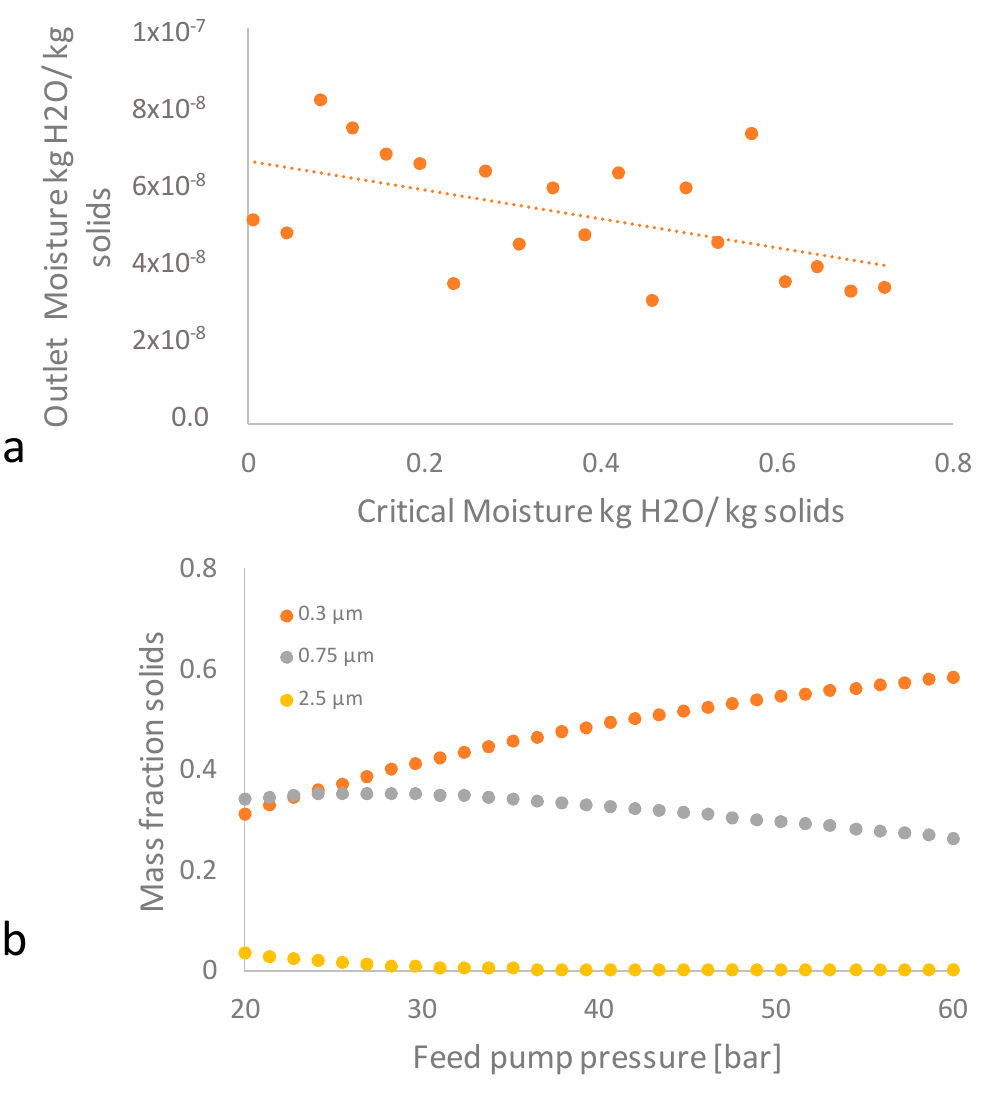
Figure 15. Sensitivity analysis at constant temperature of 52 °C: ( a ) of dependence of critical moisture to outlet product IBU moisture content demonstrating SD efficiency, and ( b ) of feed pump pressure dependence on the mass fraction IBU solid.